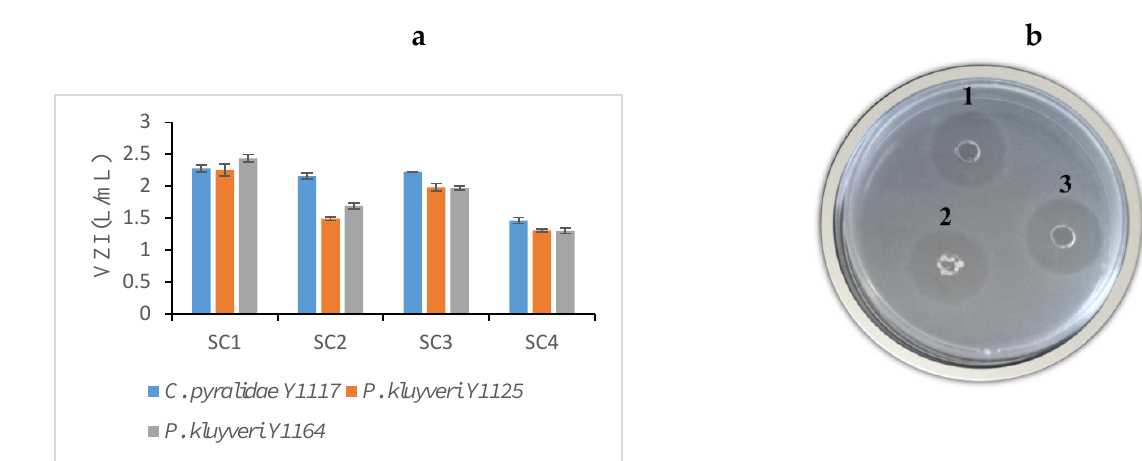
Figure 4. ( a ) Growth inhibition activity, expressed as the volumetric zone of inhibition (VZI), of the crude biopreservatives from single yeasts against spoilage yeast consortia (SC) on grape extract agar. ( b ) An example of a plate showing the VZI obtained for Candida pyralidae Y1117 (1), Pichia kluyveri Y1125 (2), and Pichia kluyveri Y1164 (3). SC1 ( D. anomala and D. bruxellensis ), SC2 ( D. anomala and Z. bailii ), SC3 ( D. bruxellensis and Z. bailii ), and SC4 ( D. anomala , D. bruxellensis , and Z. bailii ). The values are the means of three replicates with the standard deviation ranging between 0.004 and 0.09.